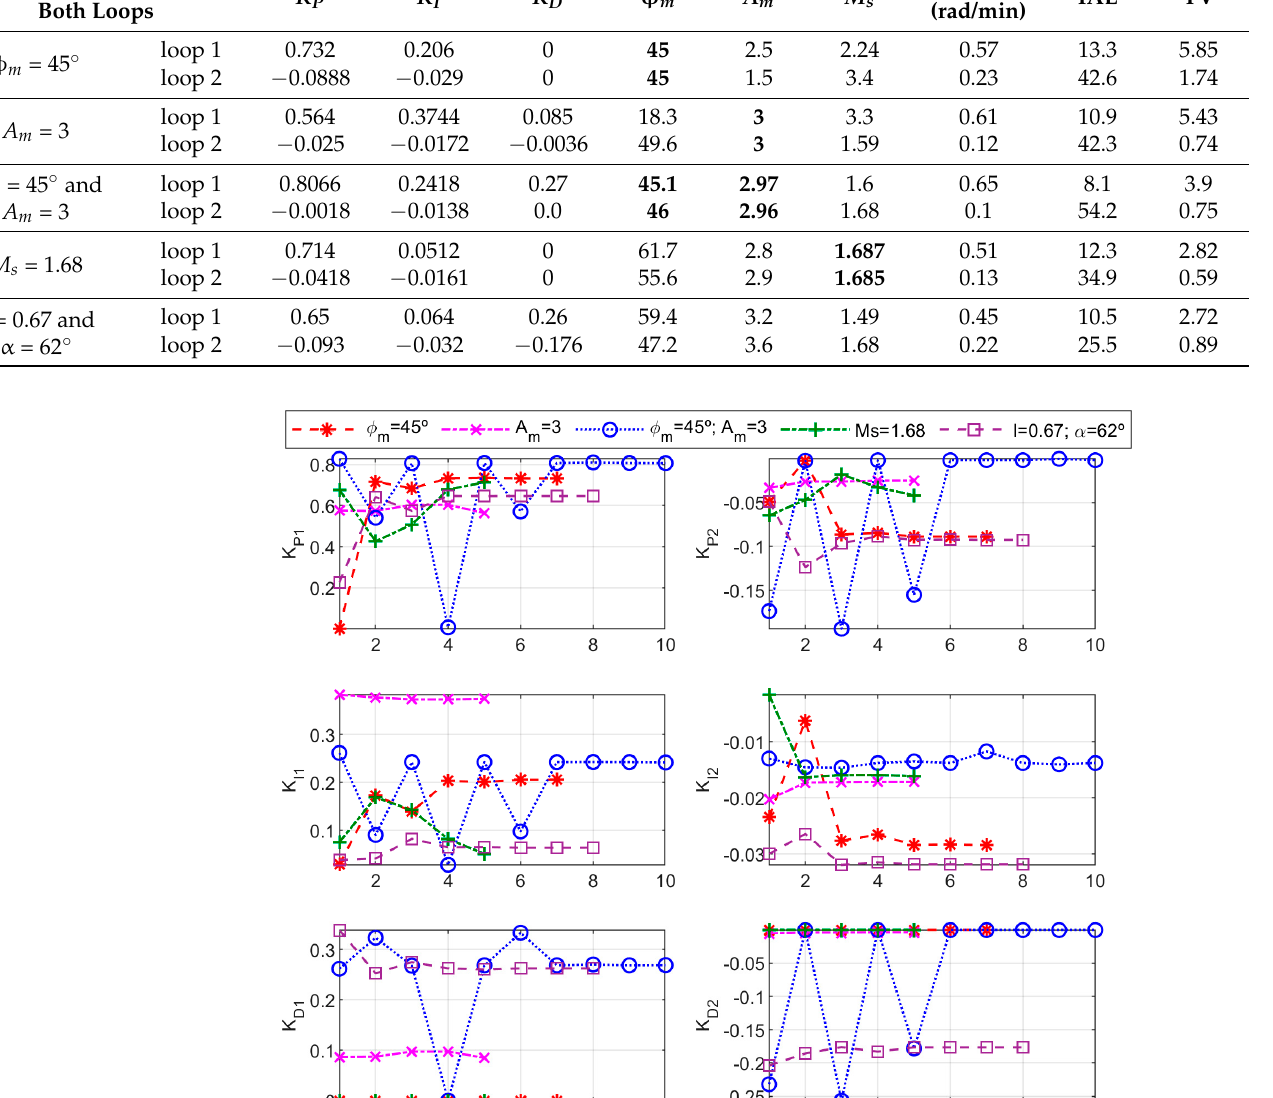
Table 1. Proposed multiloop PID controllers and their corresponding robustness and performance indices for example 1. Specifications in